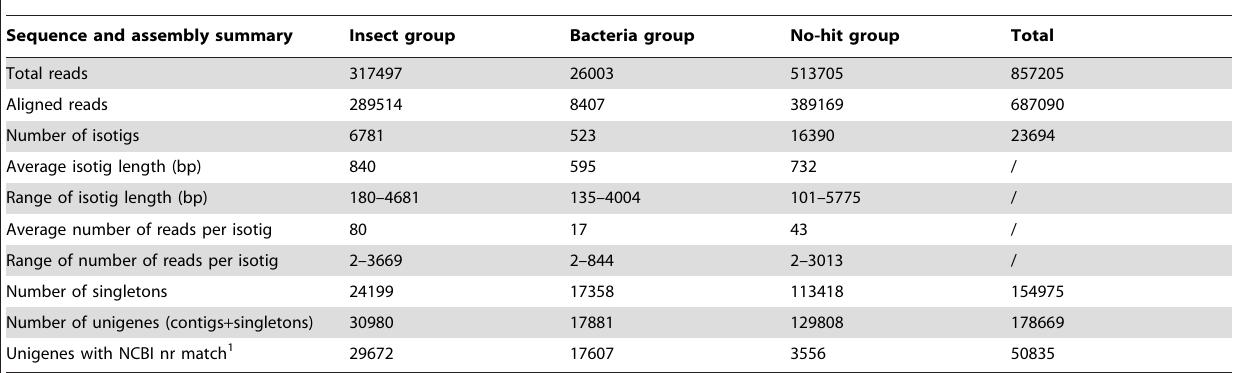
Table 1. Sequence and assembly summary of B.tabaci transcriptome.